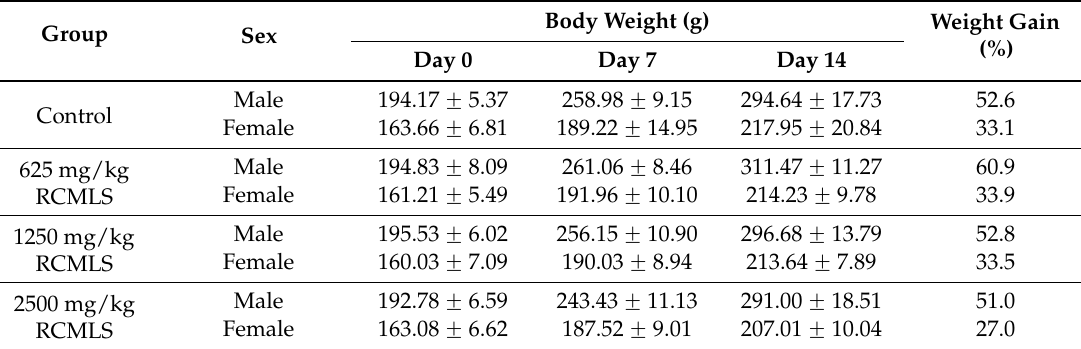
Table 4. Body weight of male and female rats in 14 days repeated oral dose toxicity study of the leaves and stems of Rubus coreanus